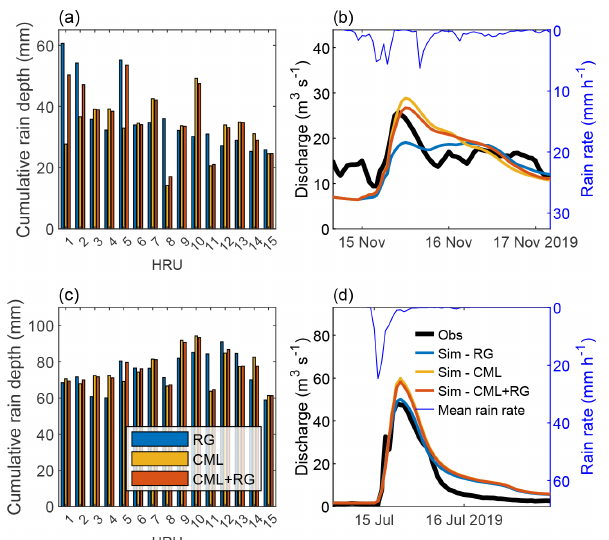
Figure 12. Panels (a) and (c) show the cumulative rainfall depth estimates from RG, CML, and CML+RG for storm/flood events 5 and 2 respectively. Panels (b) and (d) present discharge observations and simulations gathered using the three different input data types, for the two same events.